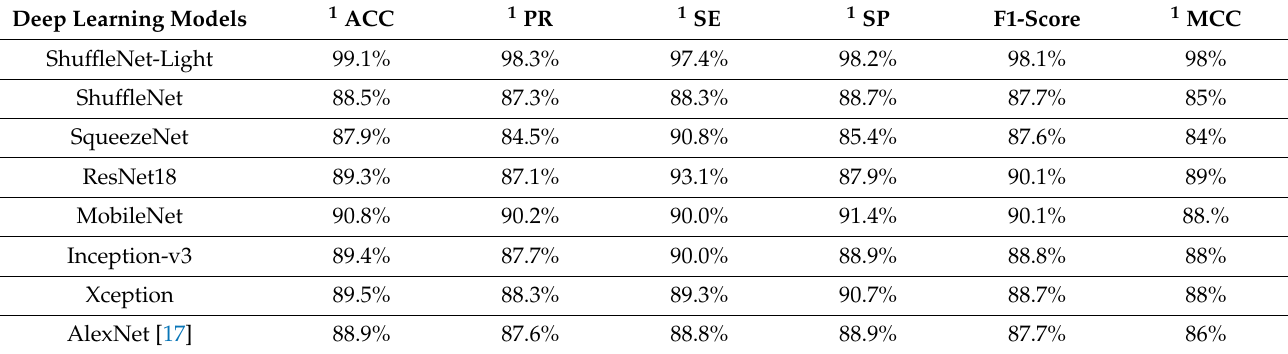
Table 7. Computational performance of the different TL-based deep learning models.